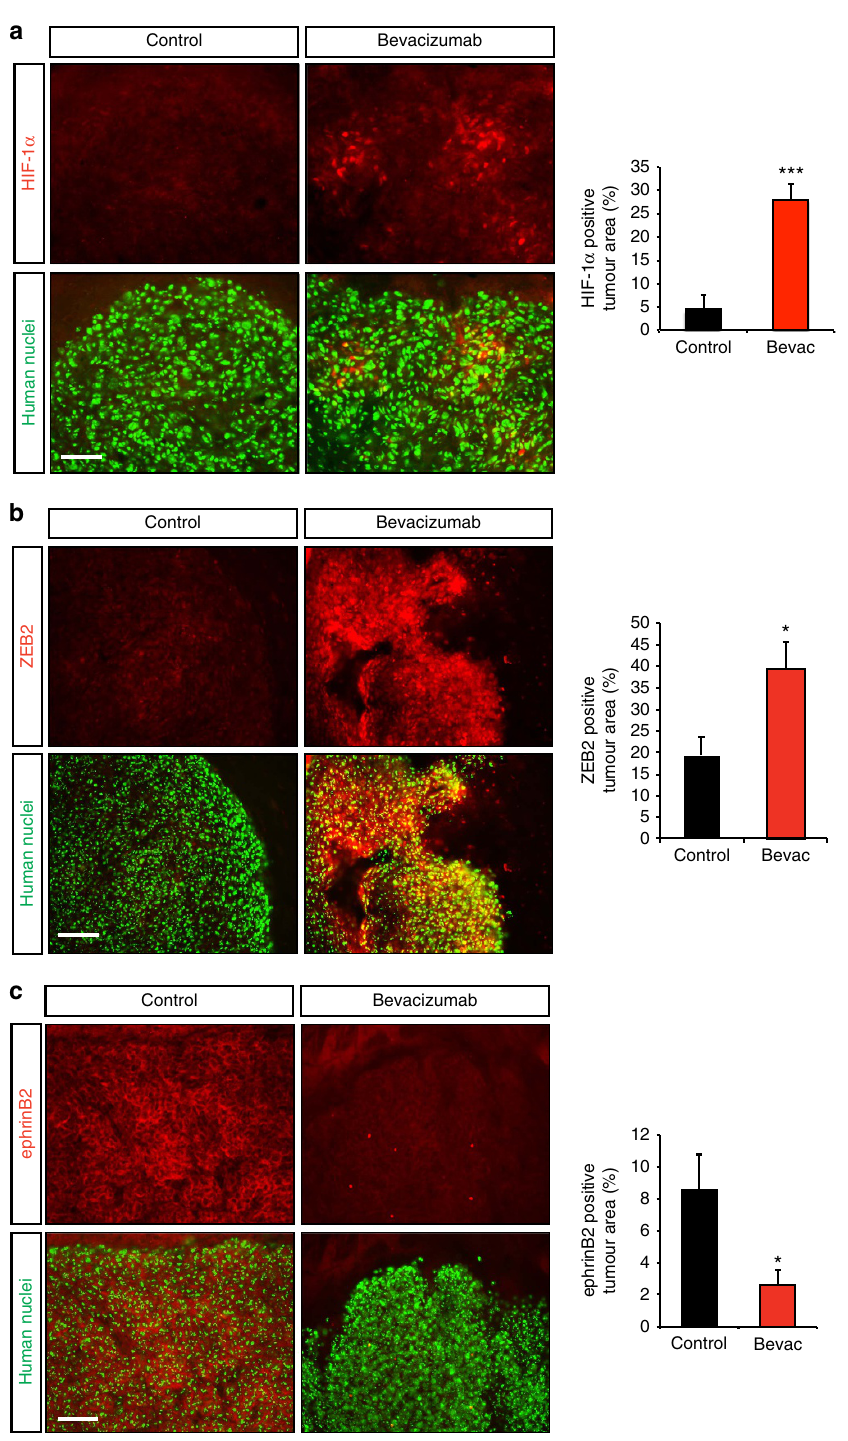
Figure 6 | The HIF-1 a /ZEB2/ephrinB2 pathway is activated following anti-angiogenic therapy. ( a – c ) Immunofluorescence analysis of intracranial G55 glioblastoma xenografts following IgG control or bevacizumab treatment (red: anti-HIF-1 a , -ZEB2, -ephrinB2; green: anti-human nuclei (tumour cells)). The graphs represent quantifications of the tumour area positive for the respective staining ( n ¼ 8 tumours). * P o 0.05, *** P o 0.001 using Student’s t -test. Scale bars, 100 m m ( a ), 20 m m ( b , c